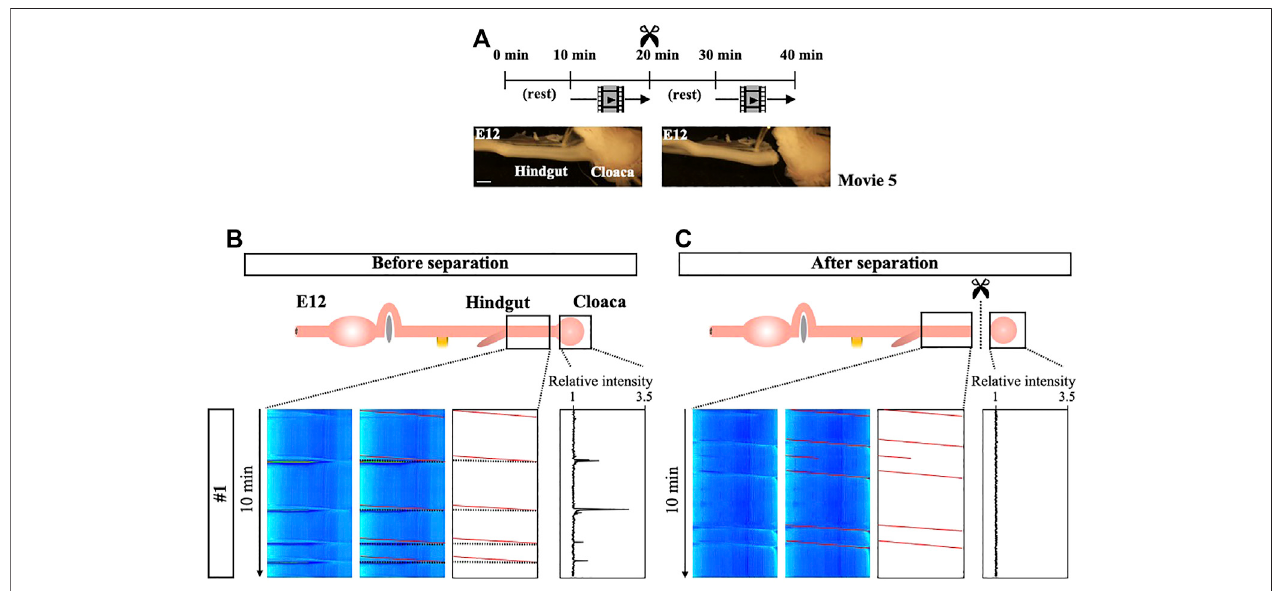
FIGURE 7 | Tight correlation between peristalsis in the hindgut and cloaca ’ s strong contraction. (A) Experimental design. After the fi rst video-recording of the cloaca-connected hindgut for 10 min, the cloaca (and its surrounding tissue) is separated from the hindgut. Following a 10 min rest, a second recording is taken. (B) Slanted lines downward to the right (red lines) represent peristaltic movements that recur unidirectionally (oral-to-aboral). These slanted red lines are frequently accompanied by horizontal lines (dotted). Since these horizontal lines are perfectly coincided with strong contraction of cloaca shown as relative intensity, these lines are consequences of stretching of hindgut being pulled by the cloaca. (C) Cloaca-disconnected hindgut continues to display the unidirectional peristaltic movements (red slanted lines). However, Horizontal lines have disappeared in the kymograph. Likewise, an isolated cloaca no longer implements strong contractions. The experiments have been repeated 5 times, and the other 4 are shown in Supplementary Figure S5 . Scale bar: 1 mm.